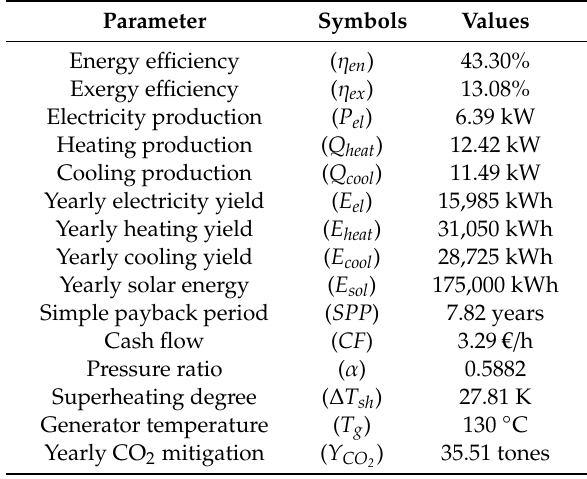
Table 4. Final results for the optimized system for minimum SPP.